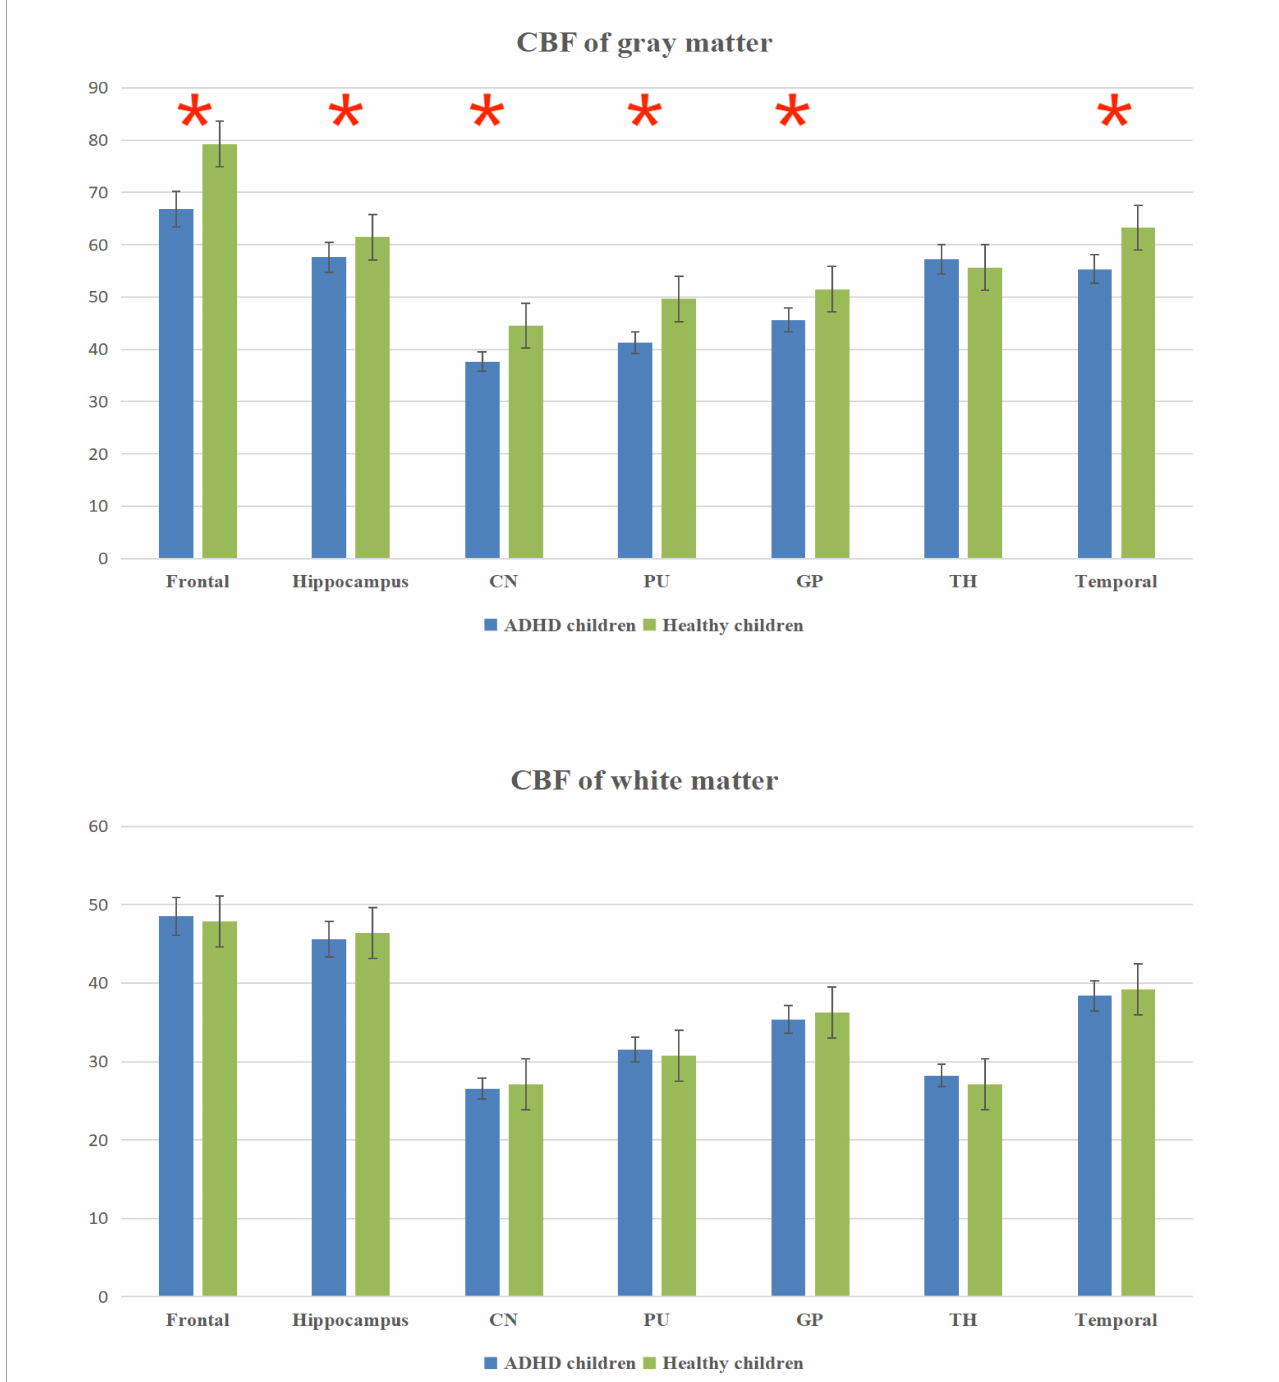
FIGURE2 Cerebral blood flow (CBF) column chart of gray matter and white matter. *Statistical significance at the level of 0.05.